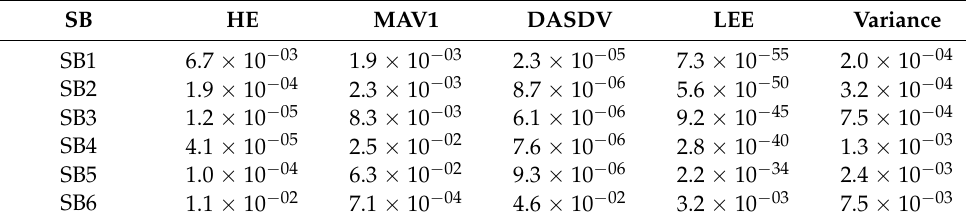
Table 3. Probability of chi (p)-Values of channel 1